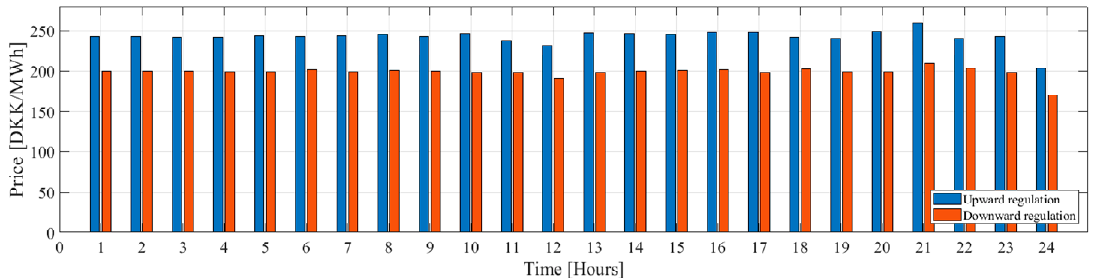
Figure 11. Hourly FCR prices for upward and downward regulation.